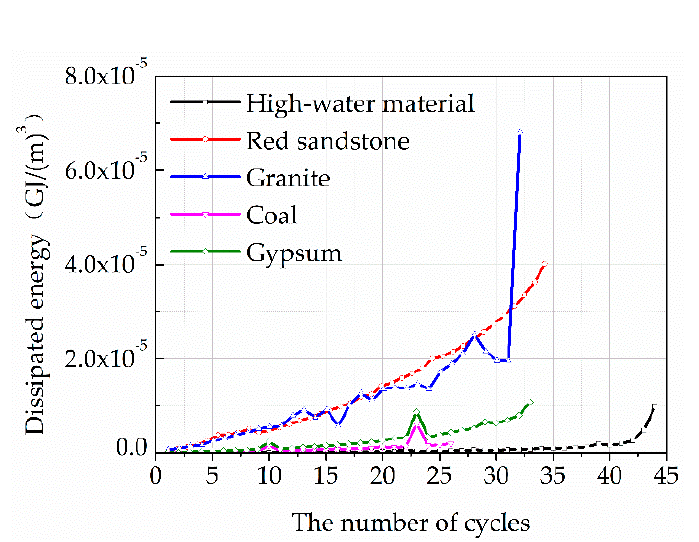
Figure 9. Variation of dissipated energy for different rocks.